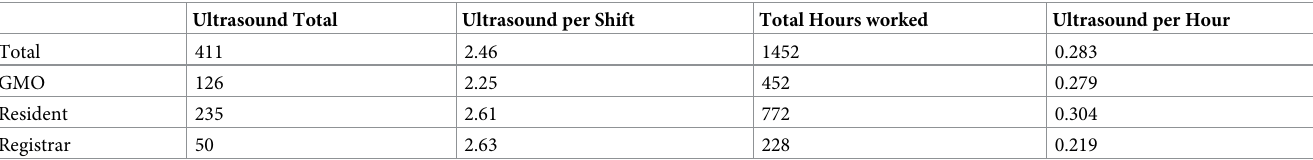
Table 3. Ultrasound frequency by level of